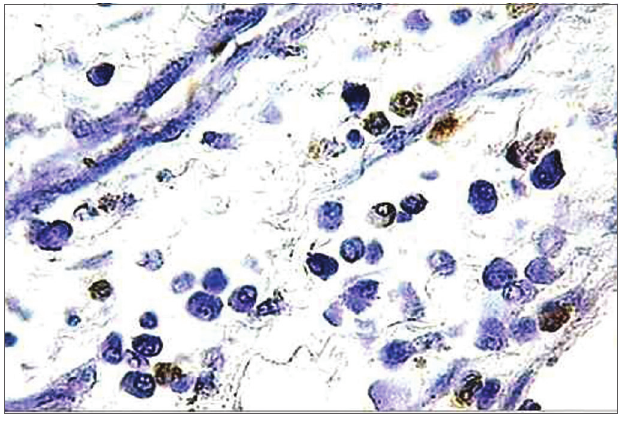
Figura 3. Histopatologia de pólipo nasossinusal eosinofílico (grupo de controle) incubado por 12 horas (TUNEL